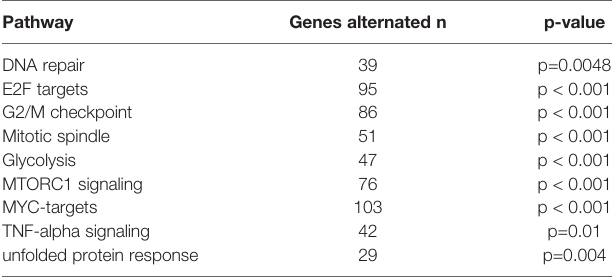
TABLE 2 | Signi fi cantly upregulated gene pathways in ccRCC primary cell cultures in gene set enrichment analysis (GSEA). Pathway Genes alternated n p-value DNA